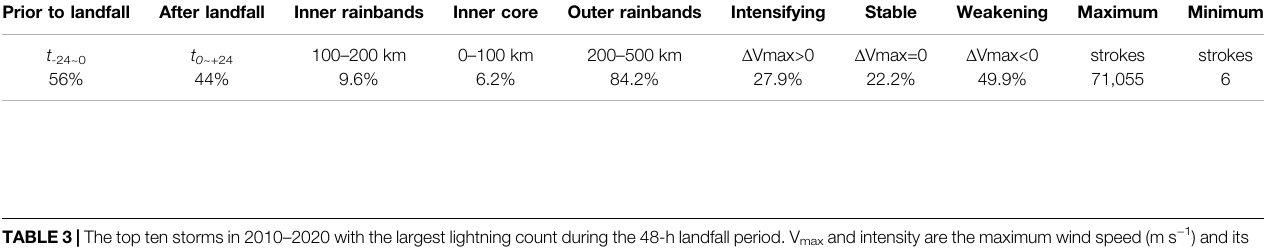
TABLE 2 | The statistics of lightning strokes at different periods, regions and stages during TC landfall. Period